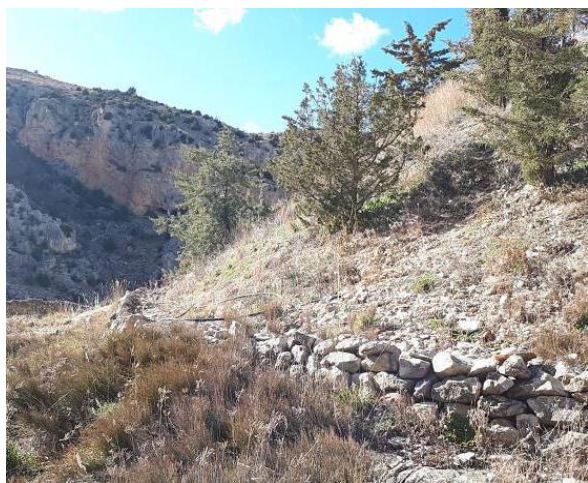
Figure 7. Historical debris dumped in the surroundings of the southern end of the city wall (J. Díaz).